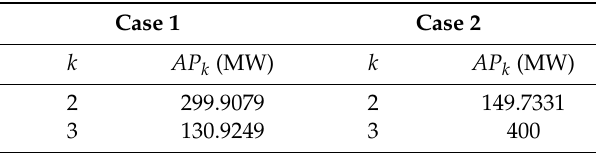
Table A1. The best solutions for system 1 found by MSFS.